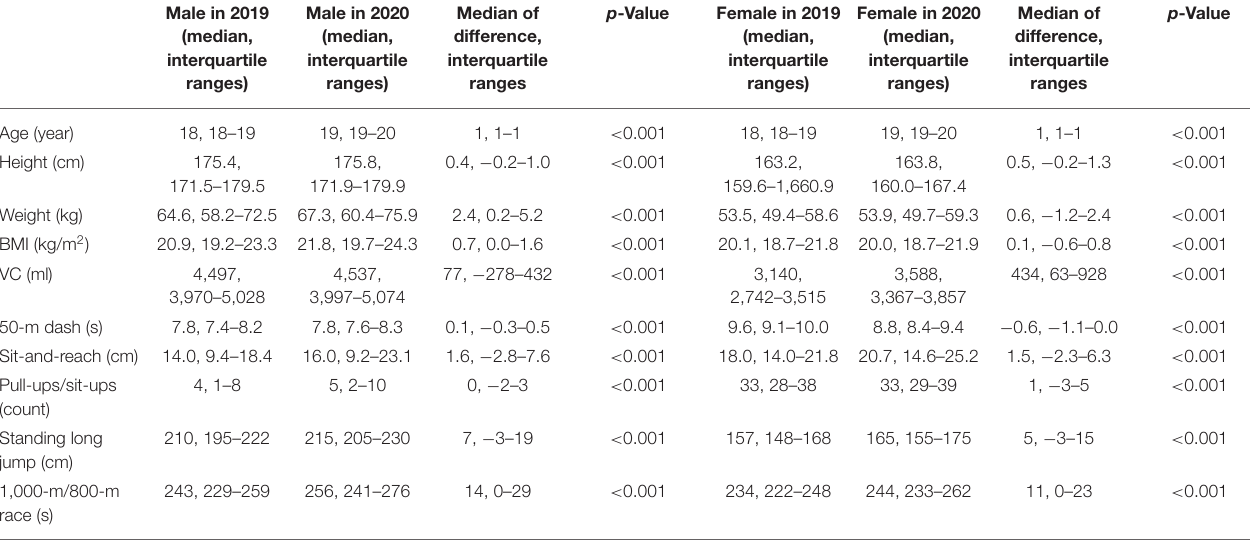
TABLE 2 | The comparison of physical fitness tests between 2019 and 2020 from 11,219 male students and 4,651 female students. Male in 2019